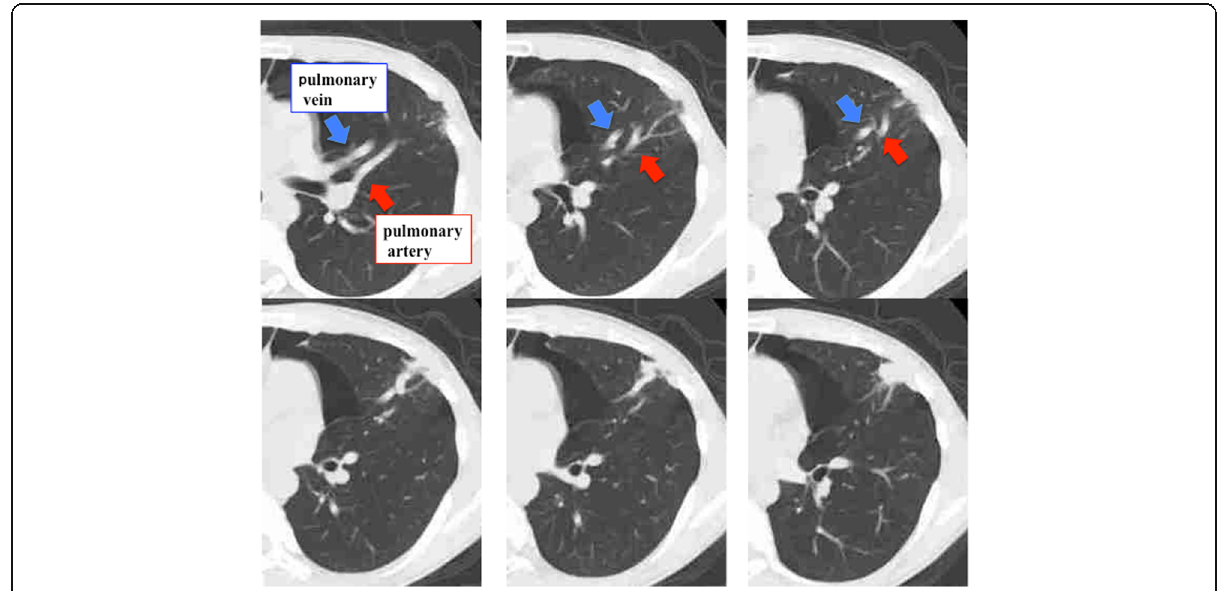
Fig. 1 Preoperative non-enhanced chest CT scan findings. The abnormally dilated pulmonary artery and pulmonary vein in the lingular segment run towards the chest wall scar remaining at the site of surgical port placement during the previous